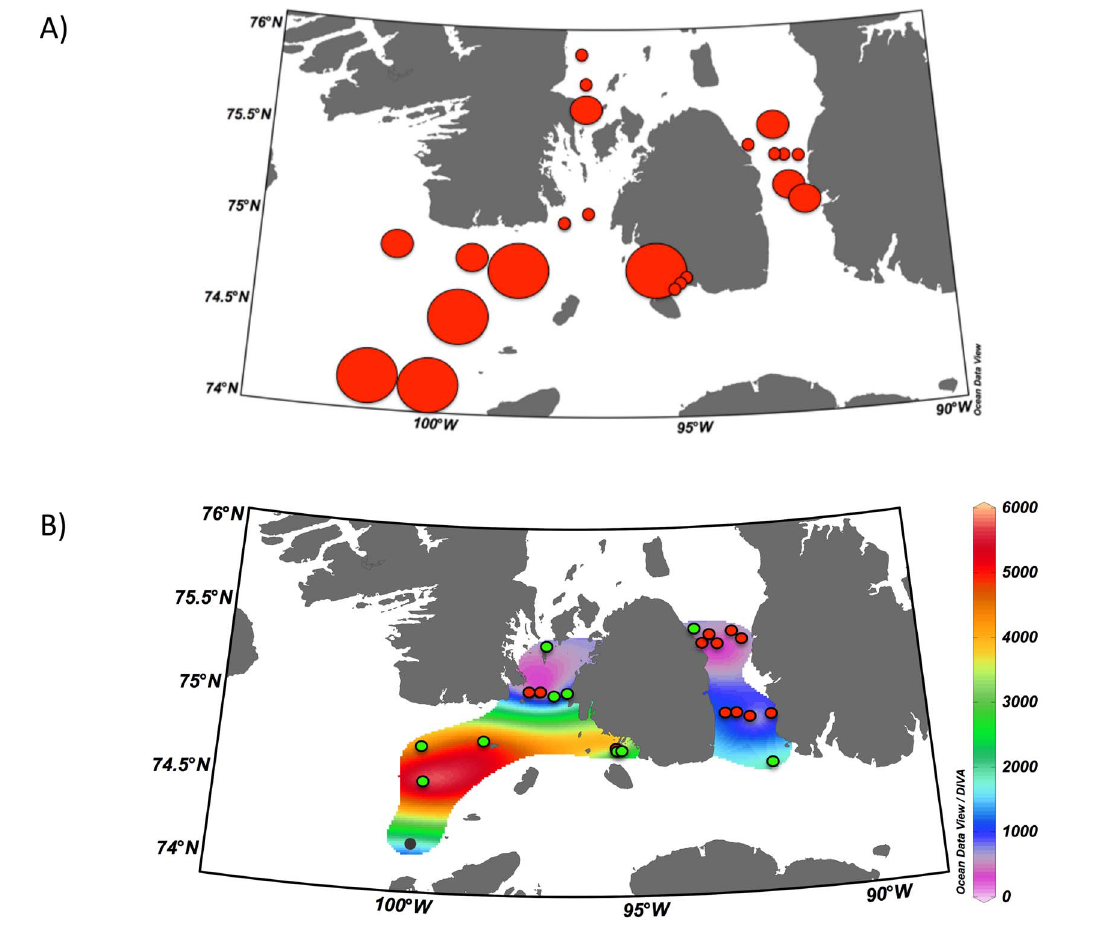
Figure 6. Distribution of C. centralis near Cornwallis Island, Nunavut, Canada. A ) Qualitative estimates of C. centralis abundances in spring, 2011. B ) Densities (cells m 2 3 ) of C. centralis in the water column in spring 2012. Interpolation of cell densities was plotted using Ocean Data View v 4.6.1 [23]. Station colours correspond to the clusters identified in Fig. 4; black indicates cluster 1, red is cluster 2 and green is cluster 3.